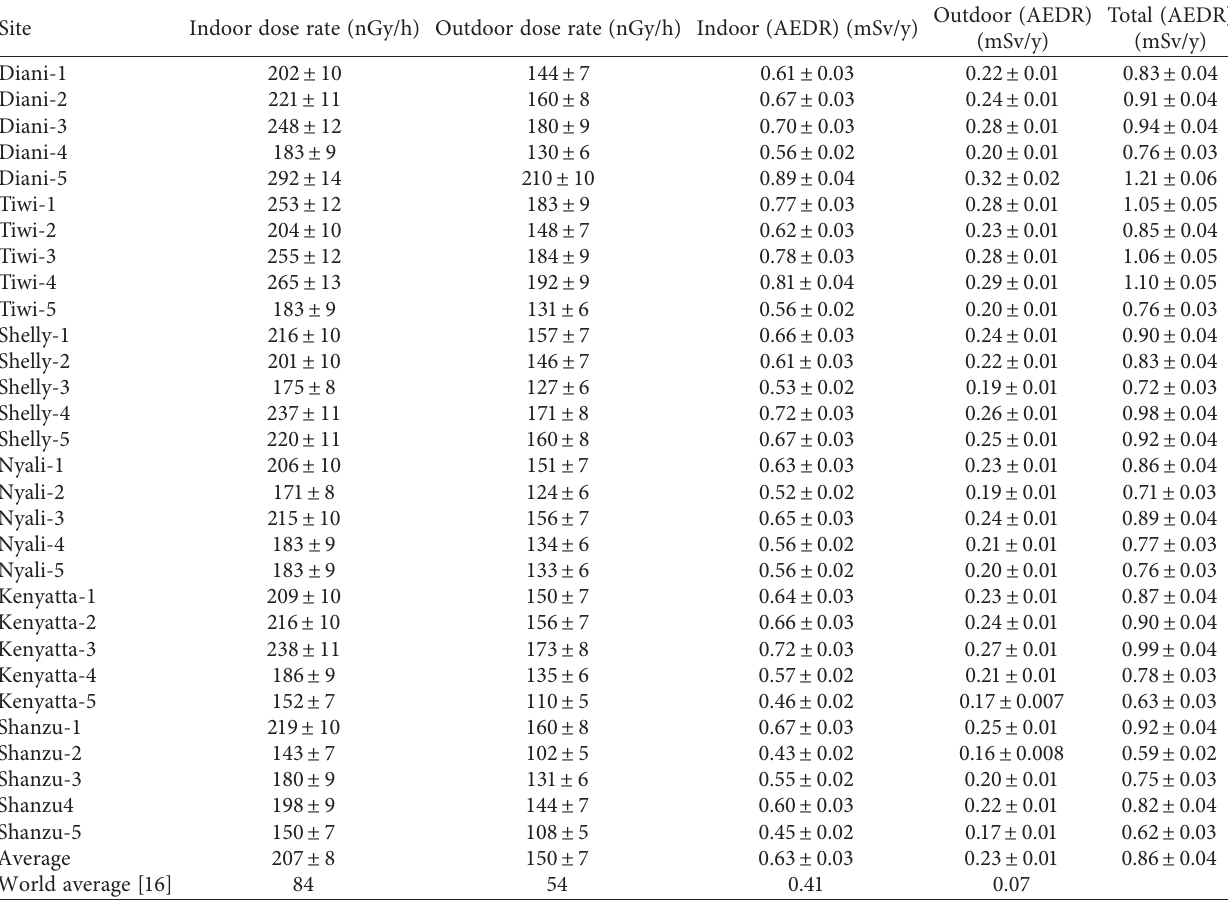
Table 4: Absorbed dose rate, annual effective dose rate, and total annual effective dose rate.